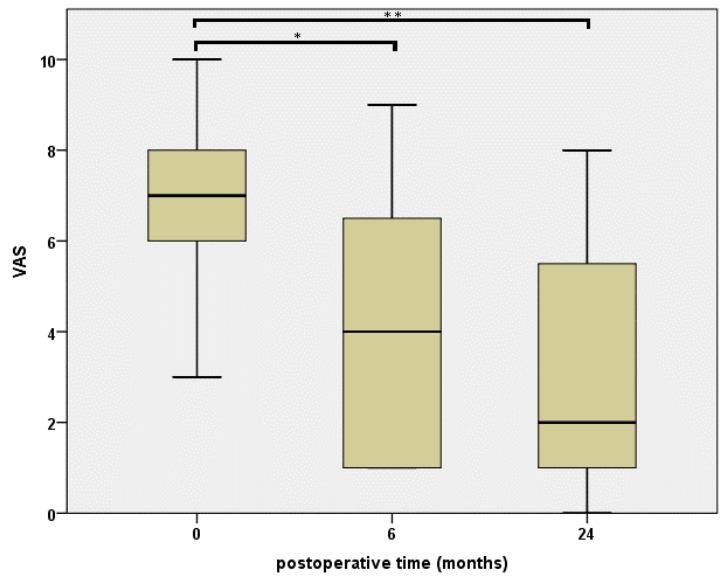
Figure 2. Pain levels via visual analogue scale (VAS) at a baseline, as well as 6 and 24 months after the intervention. P -values resulting from statistical testing are displayed using * for a p -value of <0.0001 and ** for a p -value of <0.0001.